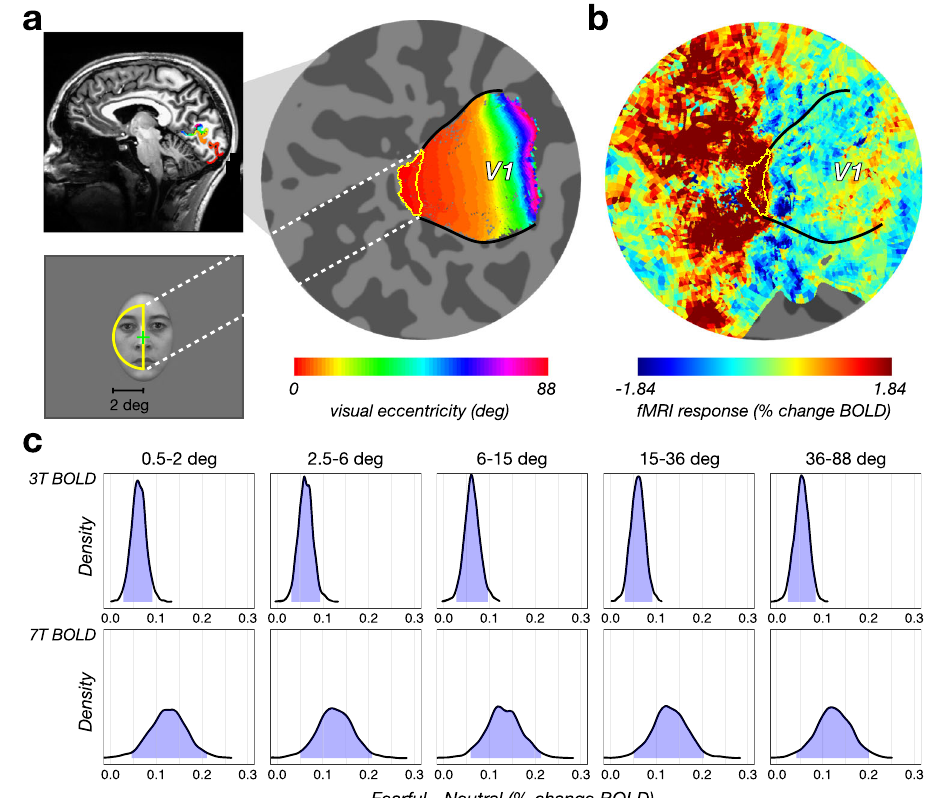
Fig. 4 | Facial valence modulation as a function of visual eccentricity. a Face stimuli (KDEF image id: AF14NE in this example) subsumed a 4deg x 6deg ellipse centered at the fovea and were expected to evoke responses in a retinotopically-identi fi ed region of V1, shown in a mid-sagittal slice (top left) and on a computationally fl attened patch of early visual cortex (right). Hue indicates visual eccentricity. Yellow contour on the fl at map indicates the retinotopiclocationofthefacestimulus(bottomleft). b Visually-evokedBOLD response to all faces (same participant as in a ). Black curves indicate V1/V2 boundary.Spatialpatternofvisualresponseexhibitsastrongpositiveresponse at the retinotopic location of the stimulus (red voxels), asurrounding negative